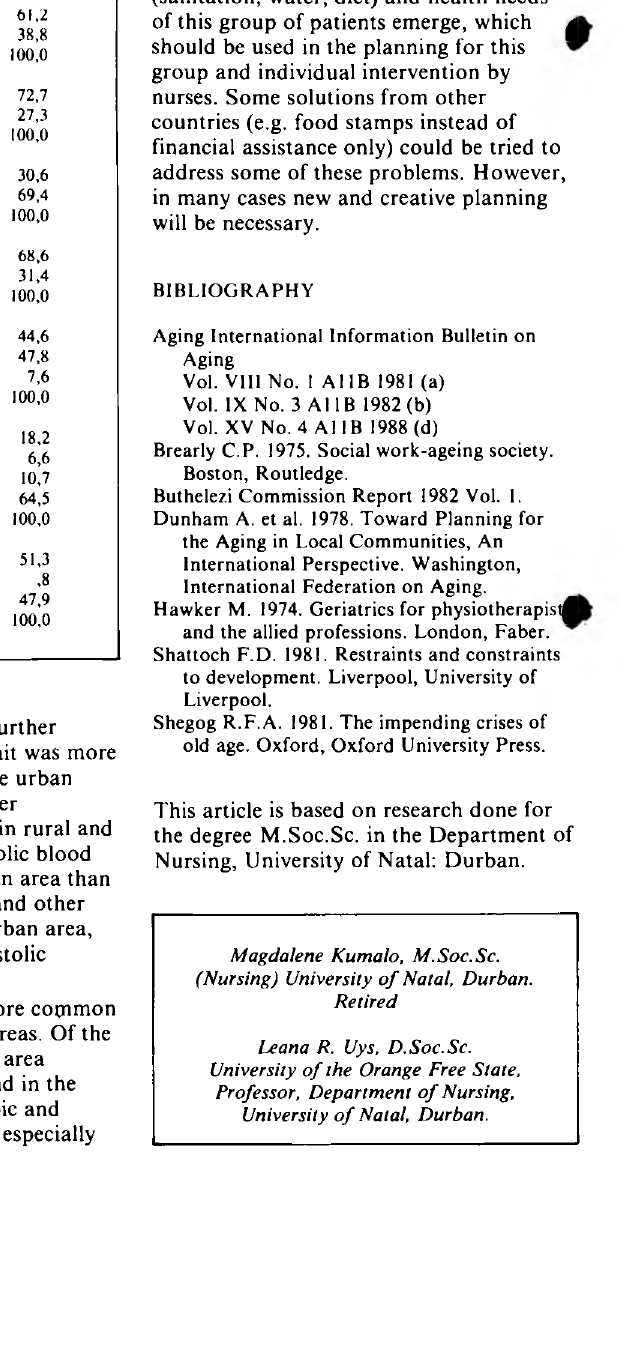
TABLE 7: Observations Of Health Indicators Posture Upright